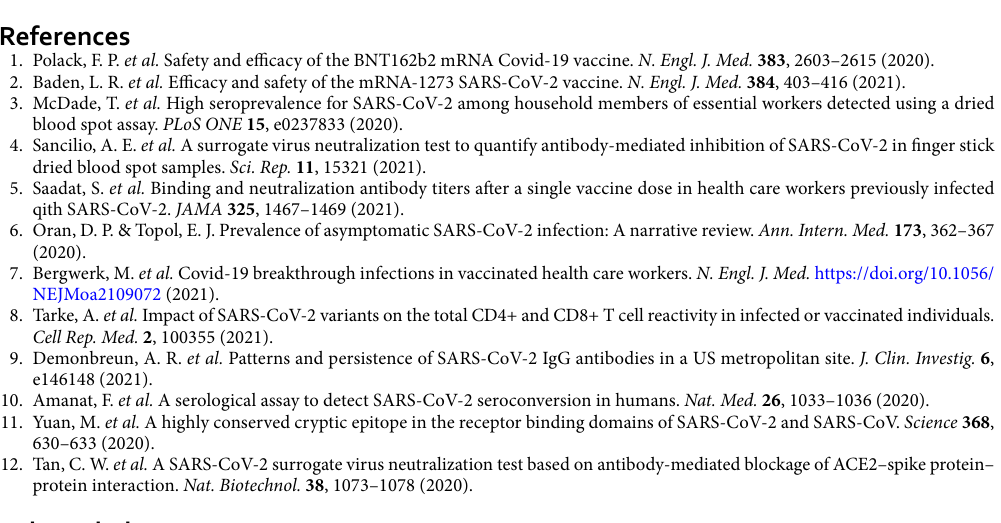
Figure 1. Level of anti-RBD IgG and in vitro neutralization of spike variants following SARS-CoV-2 mRNA vaccination. (A) Presents anti-RBD IgG antibody concentration prior to vaccination (prevax), after dose 1 (mean = 18.5 days), after dose 2 (mean = 20.7 days), and 3 months after dose 1 (mean = 95.5 days) for 27 participants. Lines connect results for individual participants, median value is shown with a dotted line, and dot color indicates history of SARS-CoV-2 exposure prior to vaccination (PCR positive confirmed COVID- 19, seropositive but asymptomatic, and seronegative). Wilcoxon matched pairs signed-rank tests were used to evaluate statistical significance of median differences. Overall, antibody concentration was significantly lower at 3 months than after dose 2 (p < 0.0001). (B) Presents inhibition of spike-ACE2 receptor binding using a surrogate virus neutralization test that measures inhibition of wild-type (Wuhan) spike, as well as the P.1, B.1.351, and B.1.1.7 variants. In comparison with wild-type, neutralization of all variants was significantly lower following dose 1, dose 2, and at 3 months (all comparisons p < 0.0001). Neutralization of each variant was significantly lower at 3 months than after dose 2 (all comparisons p < 0.001). (C) Predicts anti-RBD IgG at 3 months as a function of dose 2 response. Regression analysis indicates that the dose 2 response is a strong predictor of the 3 month response (R 2 = 0.839 (p < 0.0001). A second order in dose 2 showed evidence of a non- linear trend (R 2 = 0.898; analysis of variance for the nested model p = 0.0023). (D) Presents neutralization of each variant at 3 months post-vaccination by SARS-CoV-2 exposure history. Wilcoxon rank-sum test was used to evaluate statistical significance of differences by exposure history. Neutralization of spike-ACE2 interaction did not differ between seropositive and seronegative participants for any variant (all comparisons p > 0.2). Neutralization against all the variants was higher for PCR positive cases in comparison with seropositive and seronegative